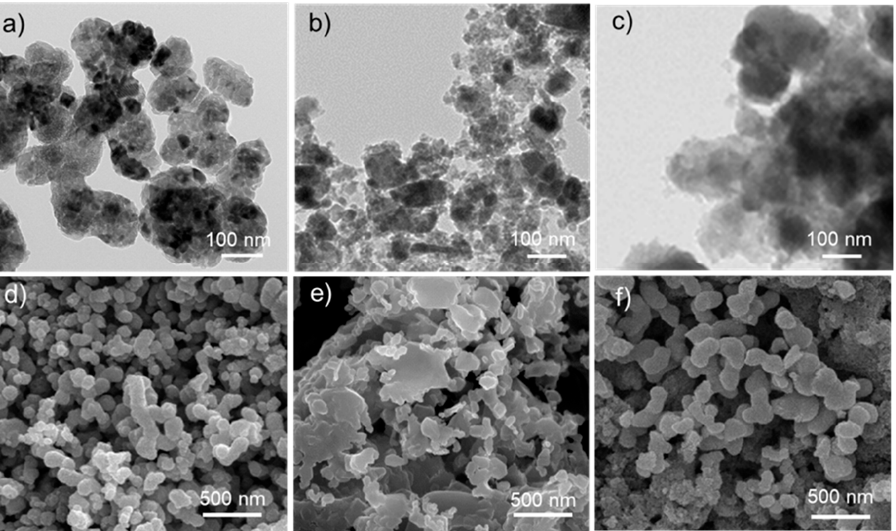
Figure 2. TEM ( a – c ) and SEM ( d – f ) images of MgAC-Fe 3 O 4 /TiO 2 ( a , d ), MgAC-Fe 3 O 4 ( b , e ), and MgAC-TiO 2 ( c , f ).